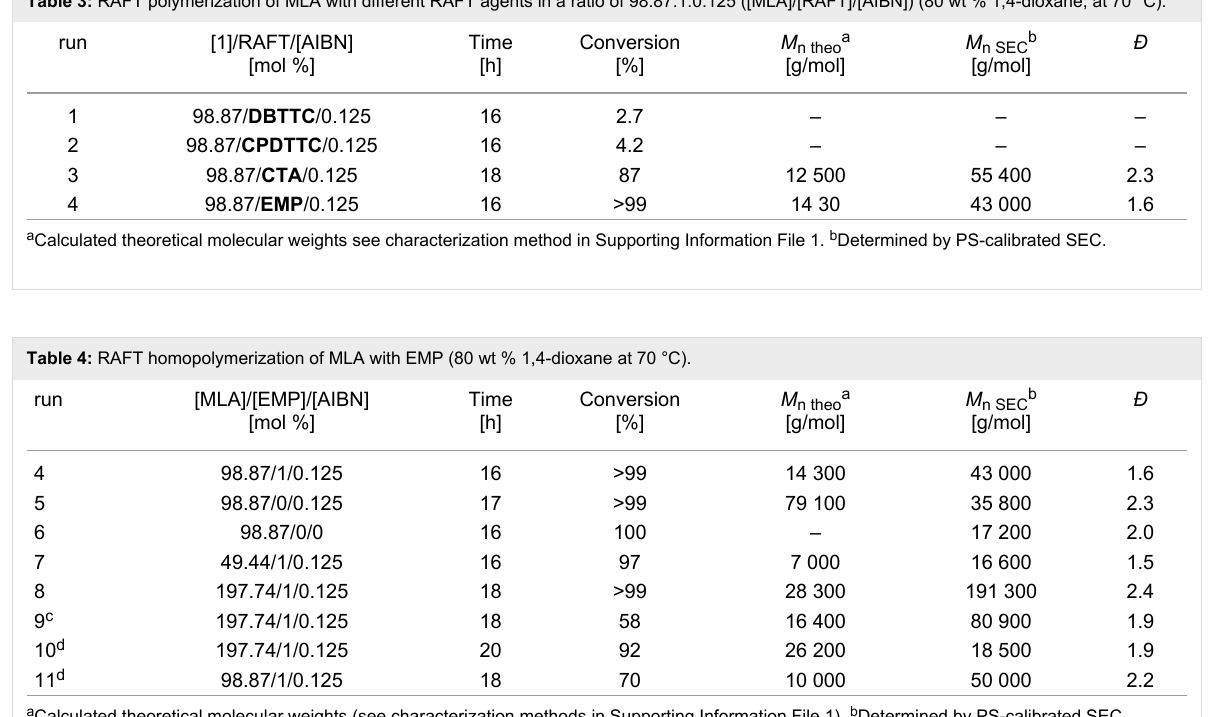
The data of the RAFT homopolymerization of MLA are sum- marized in Table 3. Only in the presence of the more polar 4-cyano-4-(((ethylthio)carbonothioyl)thio)pentanoic acid (CTA) and 2-(((ethylthio)carbonothioyl)thio)-2-methylpropanoic acid (EMP) a polymerization took place. However only with EMP narrow dispersity was achieved ( Đ = 1.6). This dispersity of 1.6 illustrates the upper limit for a successful RAFT process. Beside the good dispersity, the M n in comparison to the theoretical value M n theo. is much higher due to the known parallel running process of self-initiation. For this reason, the polymerization with EMP was further